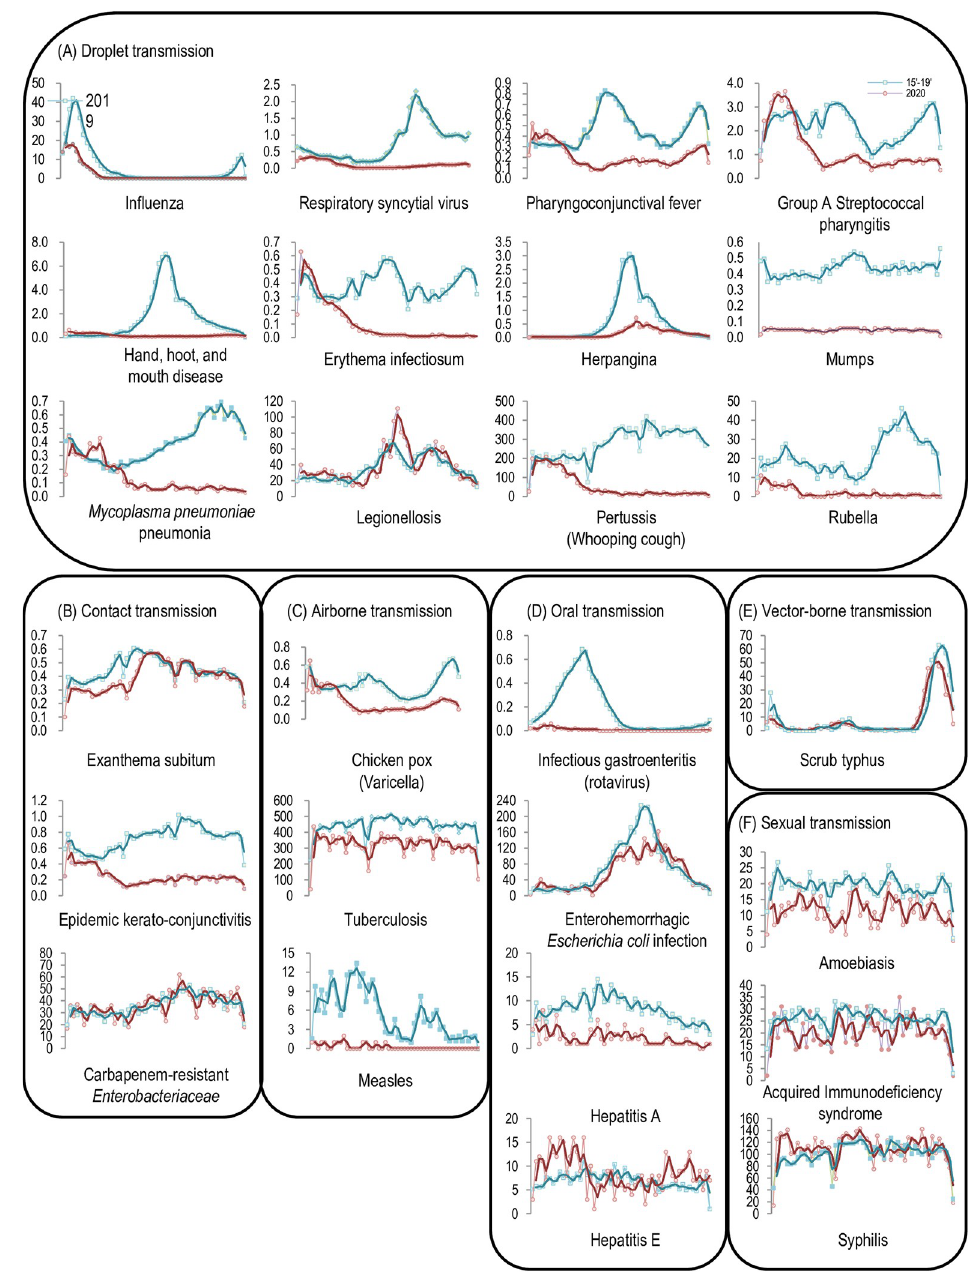
Fig 3. Epidemic curves of common infectious diseases classified according to the transmission routes. The blue thin lines () indicate the epidemic curves during 2015–2019. The scarlet thin lines () indicate the 2020 epidemic curves. The moving average lines were applied to the incidence curve of 2020 (scarlet tick line) and 2015–2019 (blue tick line) of each common infectious disease. Data were obtained from the Infectious Diseases Weekly Reports from the National Epidemiological Surveillance of Infectious Diseases by the National Institute of Infectious Diseases in Japan